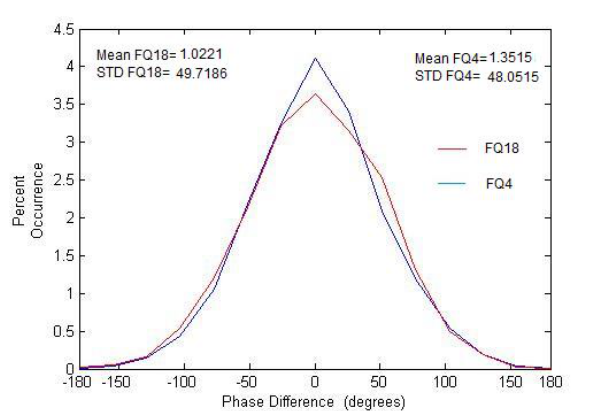
Figure 8. PPD distribution for ground